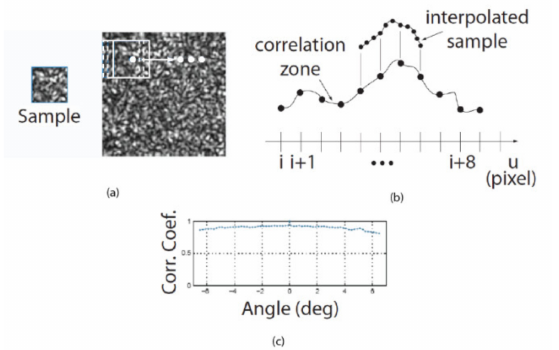
Figure A1. Sample of the speckle pattern and sweeping of the sample over the pattern ( a ). Sub- pixel interpolation of the position of the sample for which the normalized correlation coefficient is maximum ( b ). Typical plot of the evolution of the correlation coefficient as a function of the angle for one axis of one eye of the ASP ( c ).